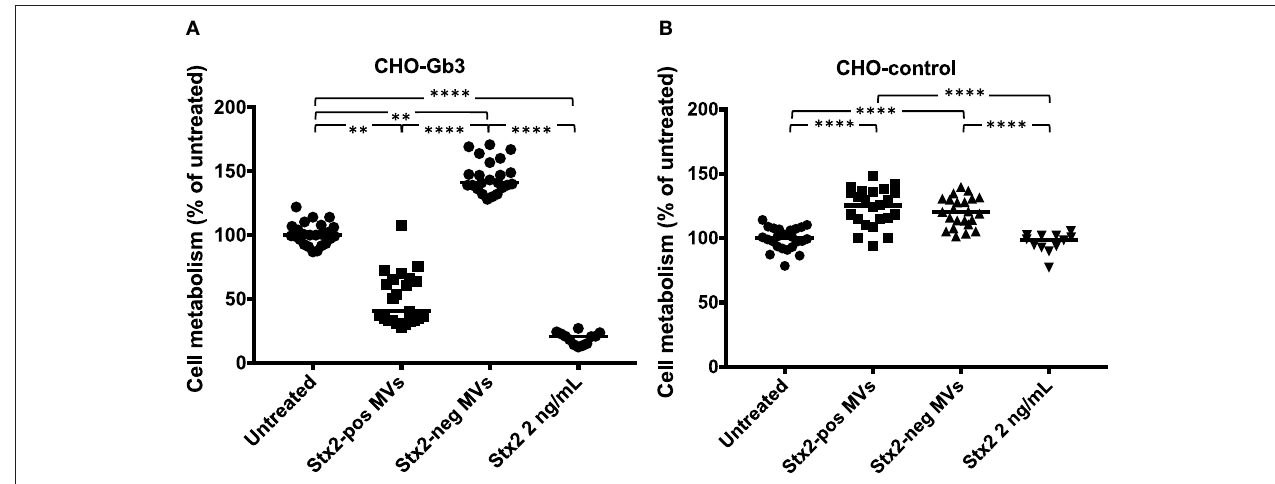
FIGURE 1 | Gb3-positive but not Gb3-negative CHO cells are susceptible to microvesicle-delivered Stx2. CHO-Gb3 and CHO-control cells were incubated with Shiga toxin 2-positive microvesicles (Stx2-pos MVs), Stx2-negative microvesicles (Stx2-neg MVs), free Stx2 or PBS and cell metabolism was measured. (A) CHO-Gb3 cells were treated with Stx2-pos microvesicles ( n = 23), Stx2-negative microvesicles ( n = 23), free Stx2 ( n = 12), or PBS ( n = 24). Stx2-positive microvesicle-treated and free Stx2-treated cells exhibited a significantly lower cell metabolism compared to cells treated with Stx2-negative microvesicles and untreated cells. (B) CHO-control cells were treated with Stx2-positive microvesicles ( n = 23), Stx2-negative microvesicles ( n = 23), free Stx2 ( n = 12), or PBS ( n = 24). Cells treated with Stx2-positive microvesicles or Stx2-neg microvesicles had a significantly higher cell metabolism compared to untreated and Stx2-treated cells. No difference between Stx2-treated and untreated CHO-control cells was found. Median cell metabolism is denoted by the bar. ** P < 0.01, **** P < 0.0001, Kruskal-Wallis test. Two independent experiments are presented.